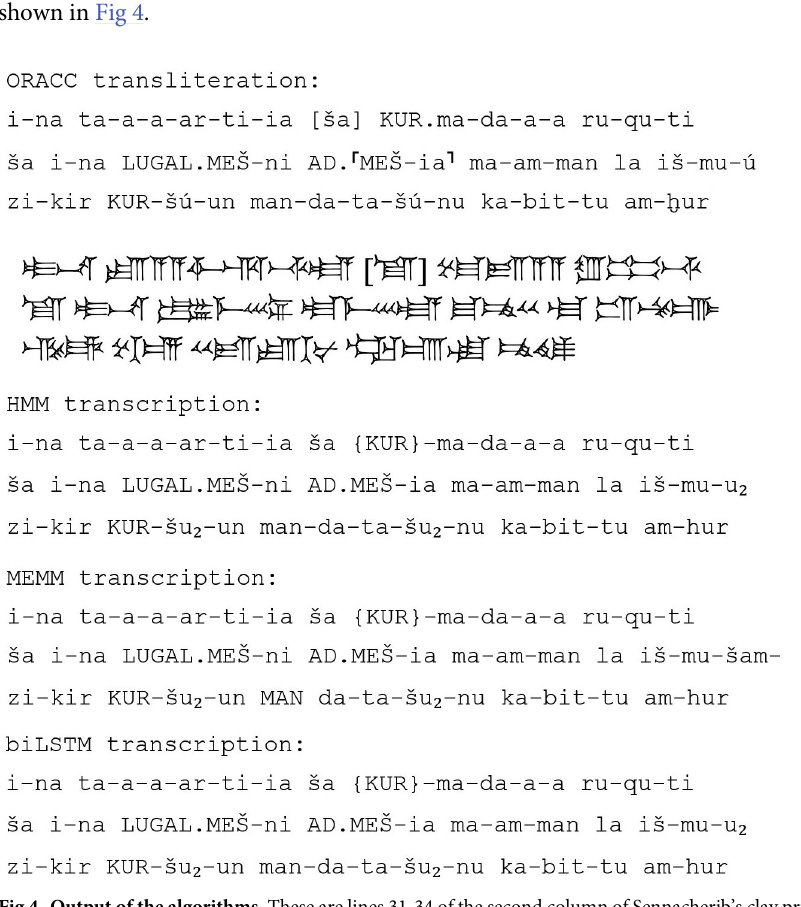
PLOS ONE | https://doi.org/10.1371/journal.pone.0240511 October 28,